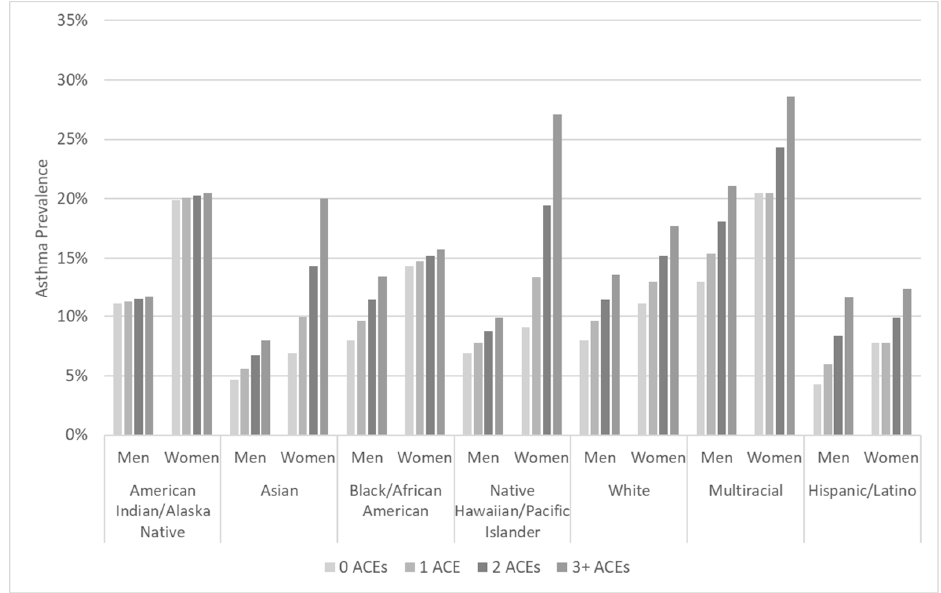
Figure 1. Asthma prevalence estimates using sex-stratified logistic regression for the interaction between race/ethnicity and number of adverse childhood experiences (0–3+), adjusted for age, education, income, smoking history, and geographic region, calculated using Behavioral Risk Factor Surveillance System 2009–2012 data.